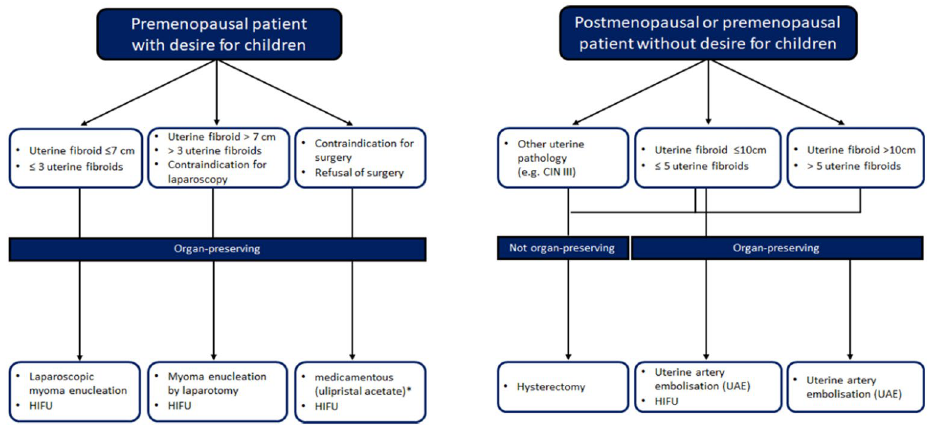
Figure 5. Treatment options for uterine